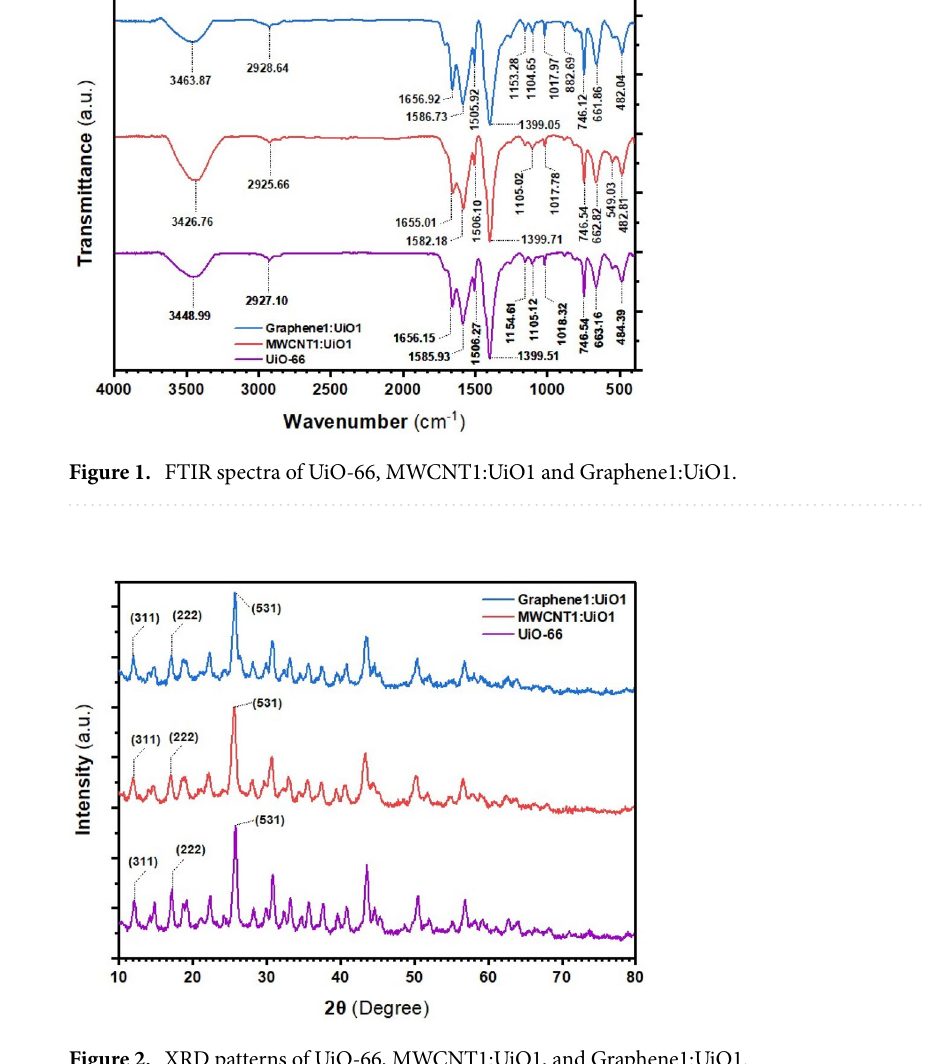
Figure 2. XRD patterns of UiO-66, MWCNT1:UiO1, and